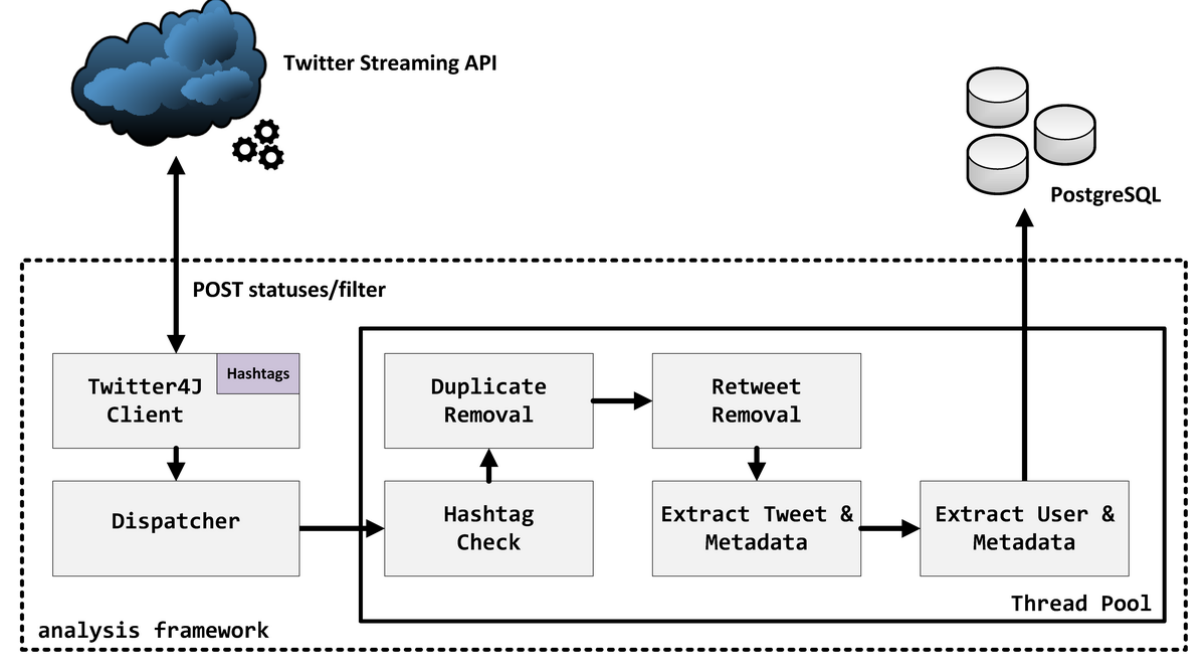
Figure 1. Workflow of the processing steps and involved software components: lines with arrows indicate processing workflow for each tweet t returned by the Twitter streaming API under the given hashtags included in this study. Each t was processed in parallel by the analysis framework to reach high-throughput processing for the large volume of COVID-19–related tweets. API: application programming